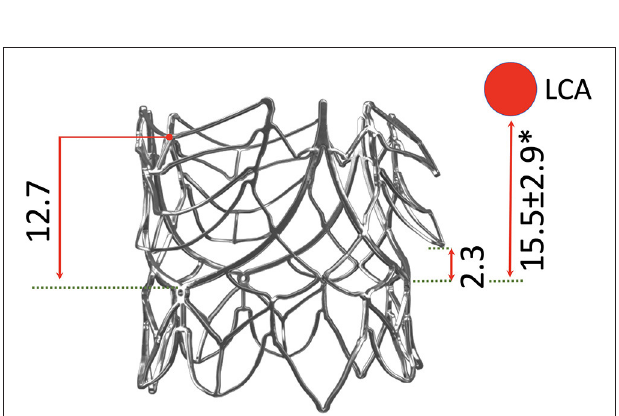
FIGURE 7 | delivery device ( n = 6). Measurements were taken at inflation increments of the balloon of 1 bar. (A) Overall shortening of the crimped valve during deployment. (B) A main feature of the SAT TAVR is that anchoring arms made of a non-shape memory alloy elevate on the basis of plastic deformation during expansion. The resulting diameter difference between waist and anchoring arms is already fully developed when the valve has only reached 60% of its maximum diameter. (C) With the supra-anular arms and the bottom flare having the biggest diameter difference to the “waist (nadir),” anchorage in compliant aortic roots is secured in both directions.